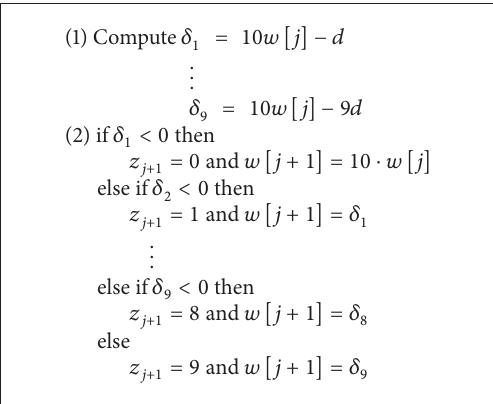
Figure 2: P-D diagram for the type2 QDS function.